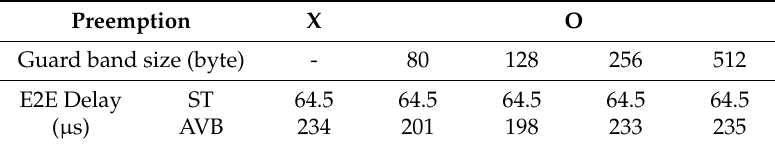
Table 4. E2E delay variation according to guard band size.